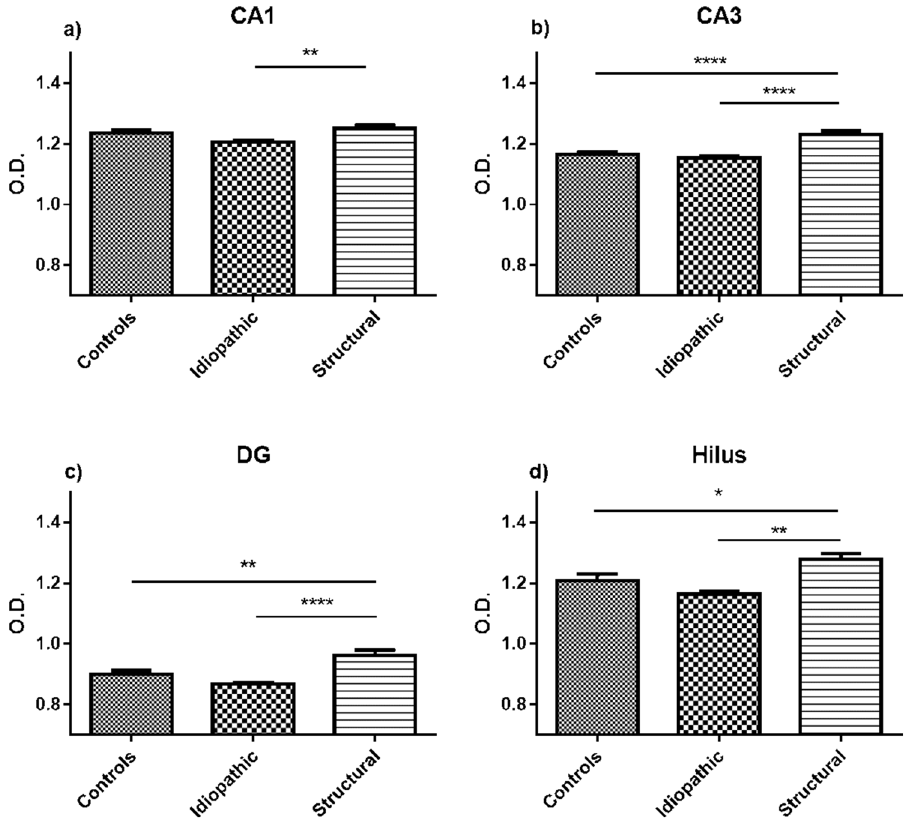
Figure 3. Analysis of intensity of CB1R expression in the hippocampus. In hippocampal sub-regions CA1 ( a ) CA3 ( b ), DG ( c ) and hilus ( d ) the structural epilepsy group showed higher O.D. compared to the idiopathic epilepsy group. Additionally, an increase in O.D. was detected in the structural epilepsy group compared to the control group. Error bars indicate SEM, * p < 0.05, ** p < 0.01, *** p < 0.0001; CA: Cornu Ammonis; DG: dentate gyrus; O.D: optical